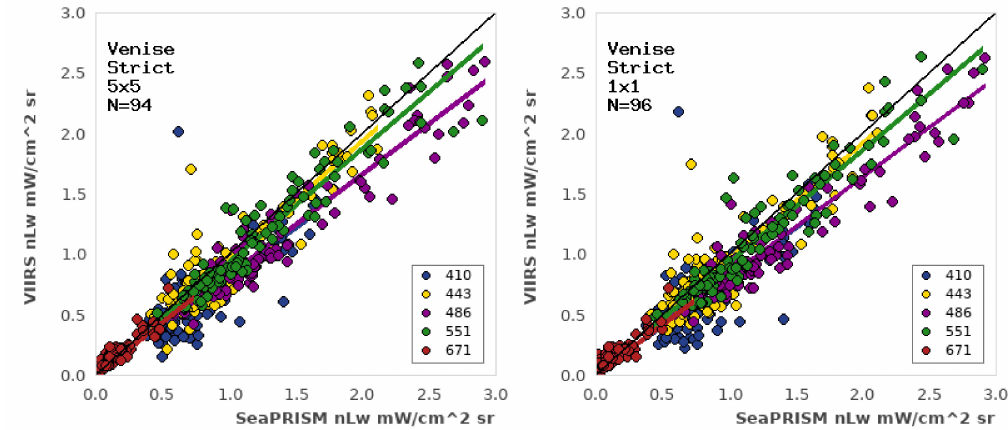
Figure 7. Venise–VIIRS comparison, June 2014–May 2019. Strict protocol, left: 5 × 5 box; right: center (in situ) pixel only. The 5 × 5 box is performing closer to the 1:1 line than the center pixel